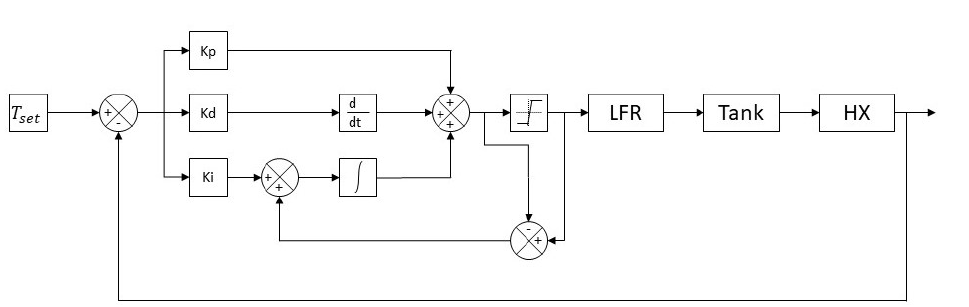
Figure 7. Schematics of the PID and the HTF loop